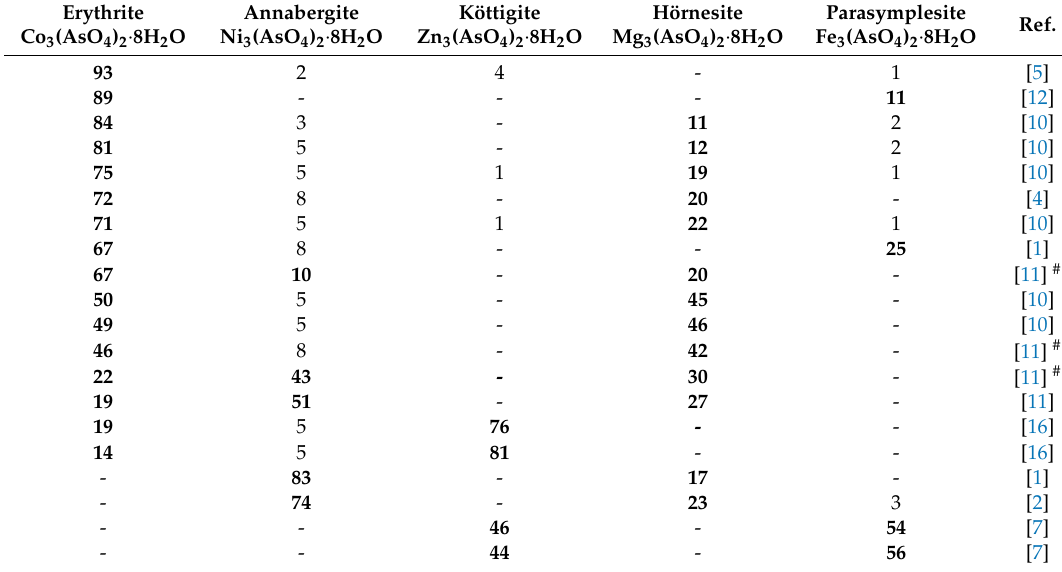
Table 1. Molecular composition (mol%) of arsenate series of the vivianite-group minerals *. Members of solid-solution series constituting > 90 mol% are in bold a